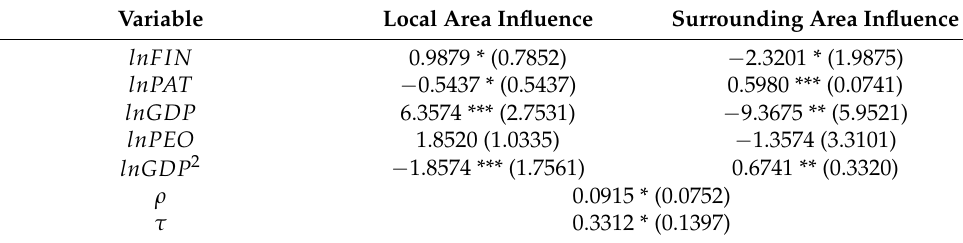
Table 3. Model estimation results of replacement space weight